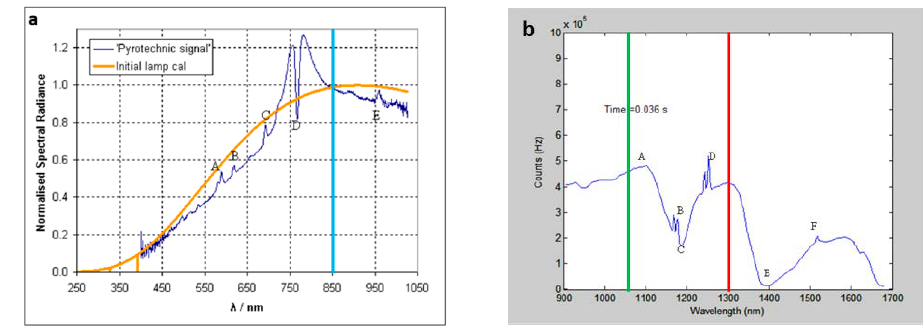
Figure 2. Pyrotechnic emission spectrum from ( a ) Si spectrometer, ( b ) InGaAs spectrometer, ~36 ms after ignition. The coloured vertical lines identify the chosen wavelength: 850 (blue line in ( a )), 1050 (green line in ( b )) and 1300 nm (red line in ( b )).